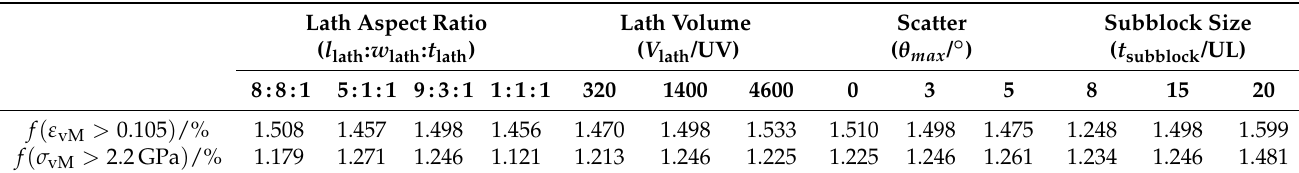
Figure 10. Spatially resolved results of a 3D RVE in a section normal to the rolling direction: Inverse Pole Figure (IPF), equivalent strain, and equivalent stress. Table 4. Fraction of points above the threshold value for stress and strain. The threshold values are selected to obtain around